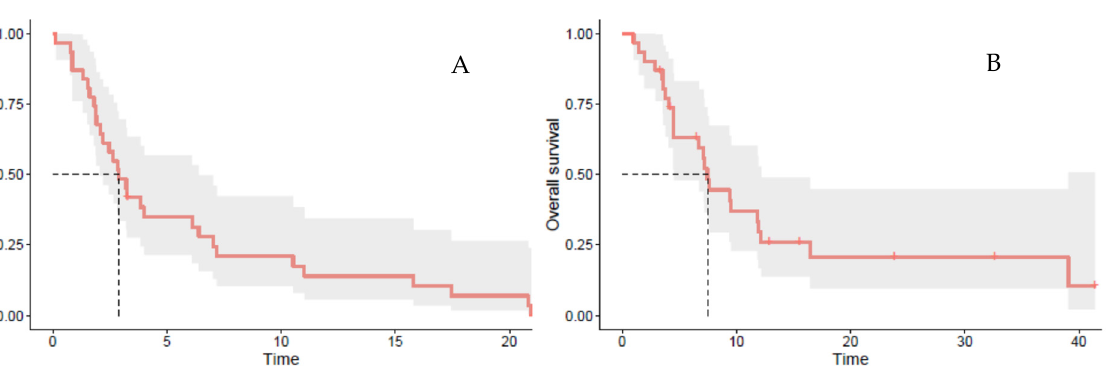
Figure 1. ( A ) Progression-free survival and ( B ) overall survival with chemotherapy ± targeted therapy post immune checkpoint inhibitor(s).